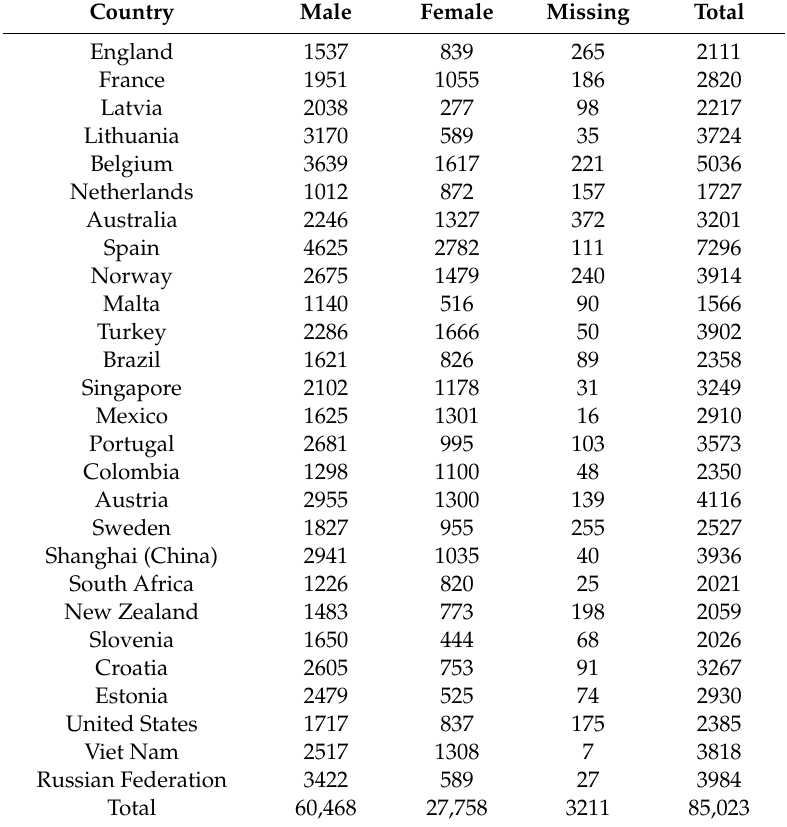
Table 2. Sample distribution of the